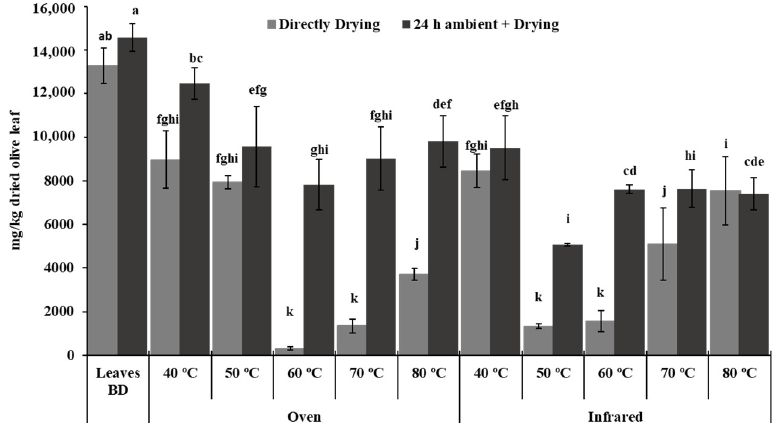
Figure 3. Polyphenol concentration (mg/kg dried olive leaf) after different heat treatments. Leaves were directly dried after harvesting or after a storage period of 24 h at ambient temperature. All the heat treatments were performed until the weight was constant. Data are expressed as the mean value of triplicate. Bars mean the standard deviation. BD means before dehydration. Vertical bars with different lowercase letters indicate significant differences according to Duncan’s multiple range test ( p < 0.05).